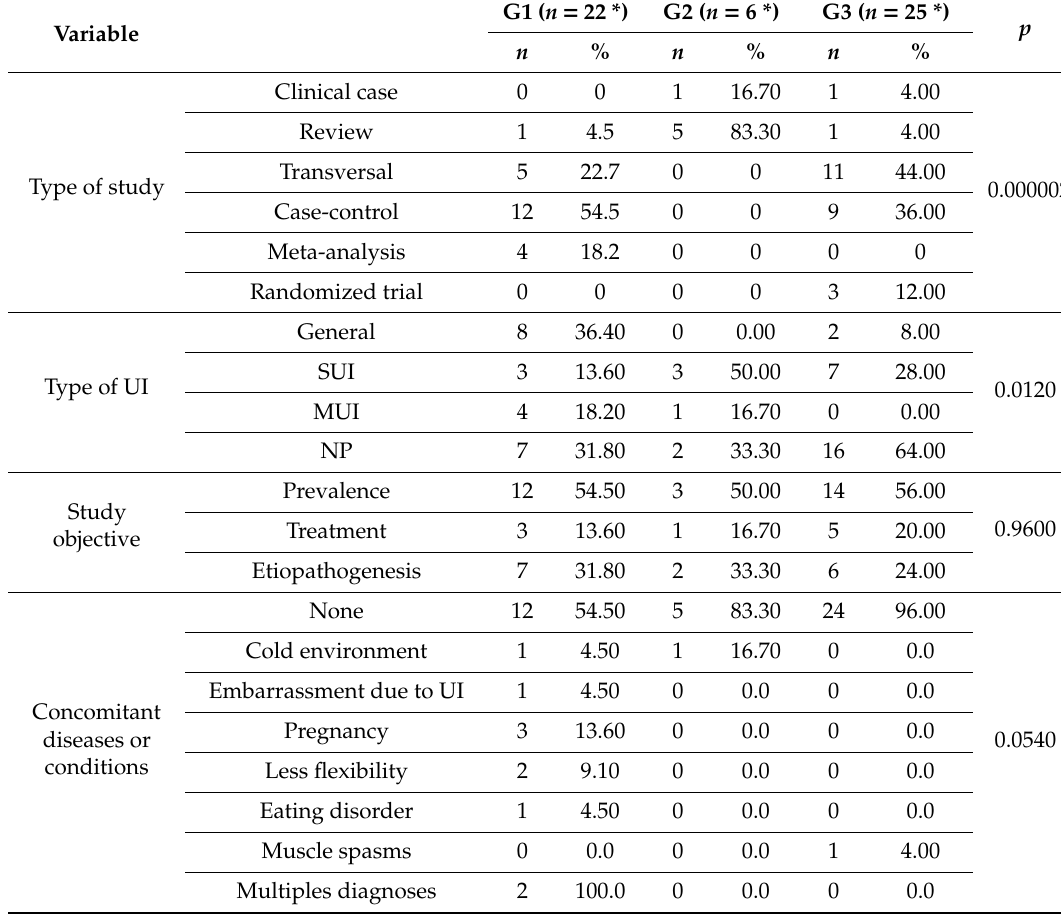
Table 2. Type of studies, type of urinary incontinence investigated, study objective and concomitant diseases or conditions in high-performance